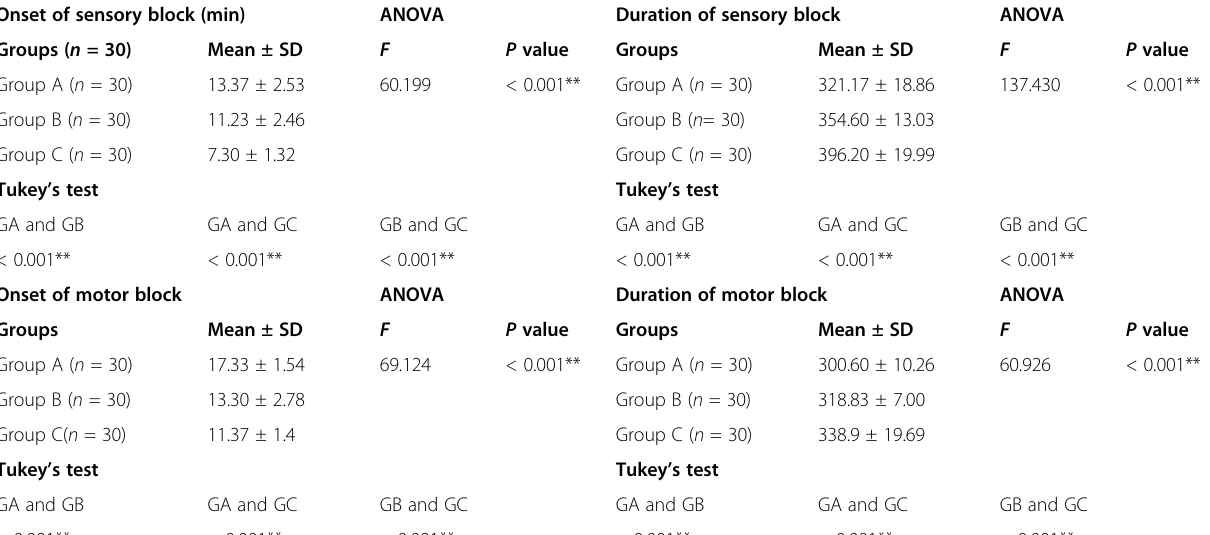
Table 3 Comparison between the three groups as